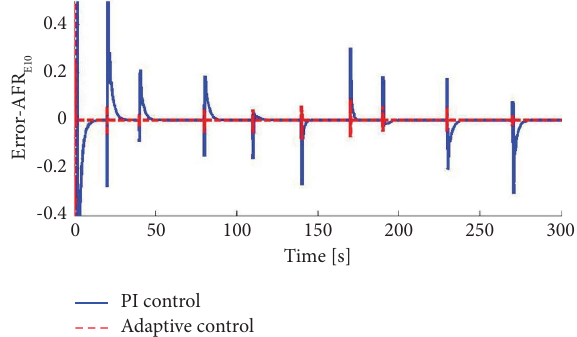
Figure 5: AFR control error for the E10 blend.